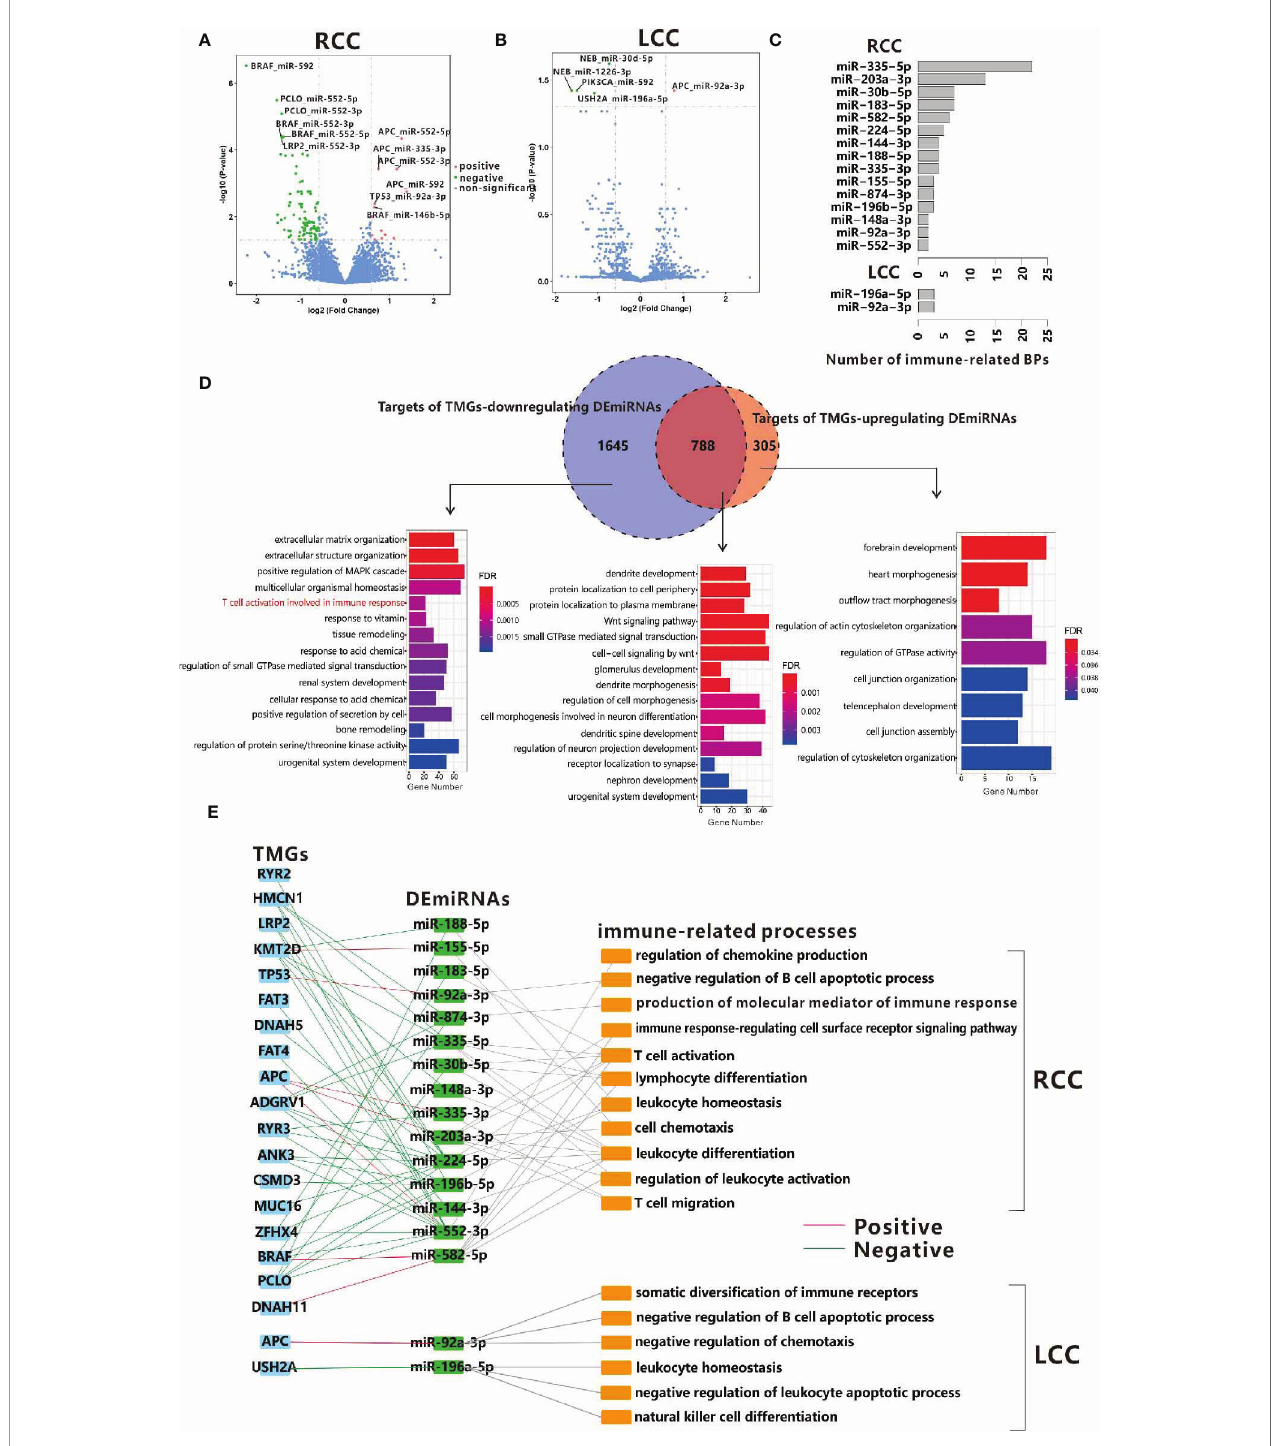
FIGURE 5 | Associations between TMGs and DEmiRNAs in RCC (A) and LCC (B) . (C) The number of immune-related BPs in target genes of DEmiRNAs regulated by TMGs in RCC and LCC. (D) Venn diagrams show the overlap between the targets of TMG-downregulating DEmiRNAs and the targets of TMG-upregulating DEmiRNAs in RCC. The bar plots show the GO functional enrichment analysis of the corresponding parts of genes in the Venn diagram and the immune-related BPs are marked in red. (E) The crosslinks among TMGs, DEmiRNAs, and immune-related BPs in RCC and LCC. The red line represents positive relationships while the green line represents negative